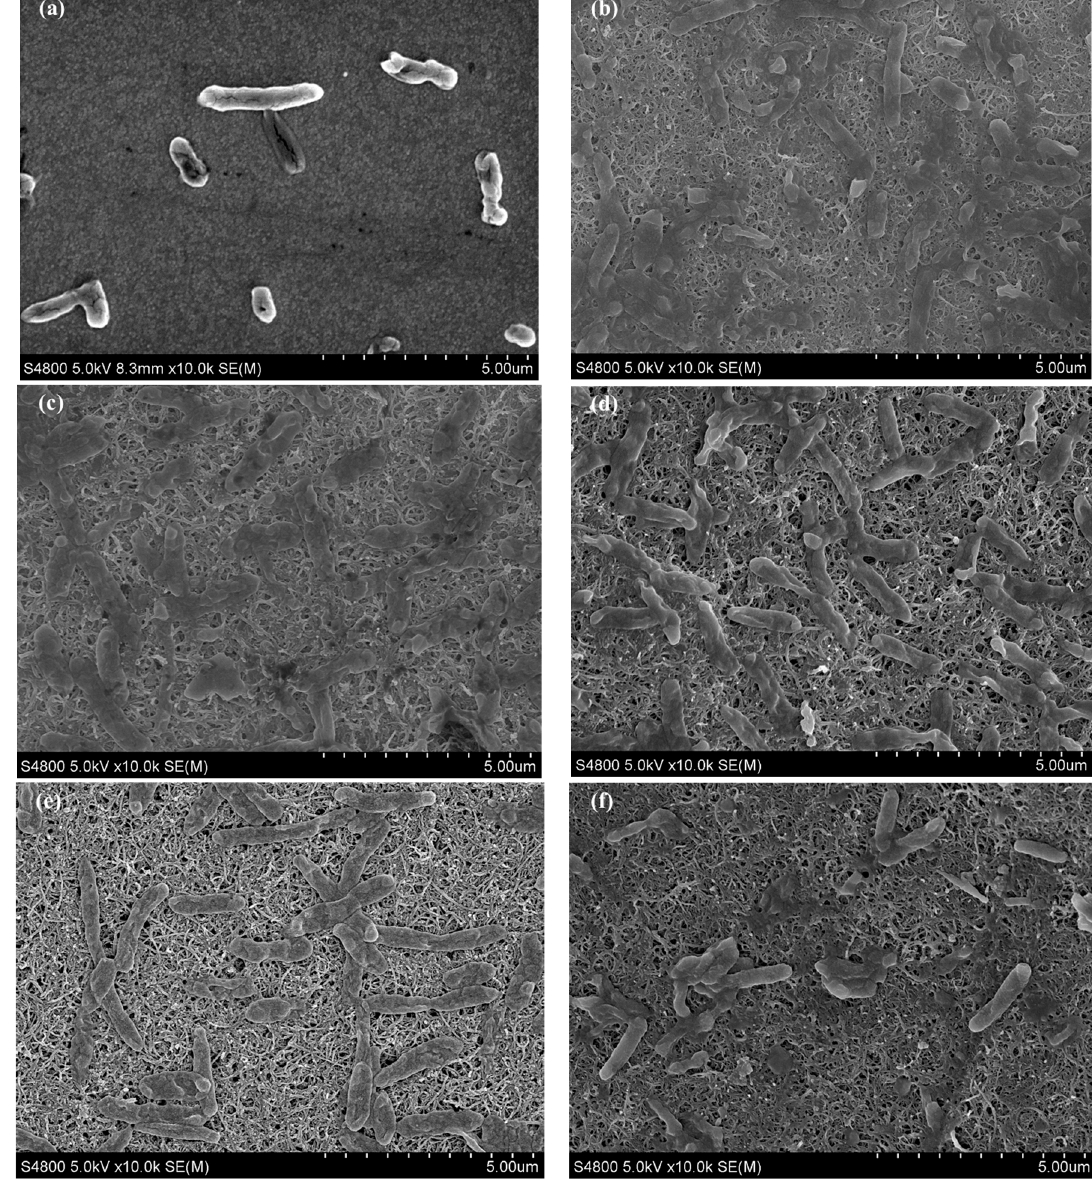
Figure 4. SEM images of S. loihica PV-4 cells on the surface of ITO electrode ( a ) and (CNTs/PANI) n /APTES/ITO electrode after 25 h of electrochemical culture ( b : 3; c : 6; d : 8; e : 12; f : 15).